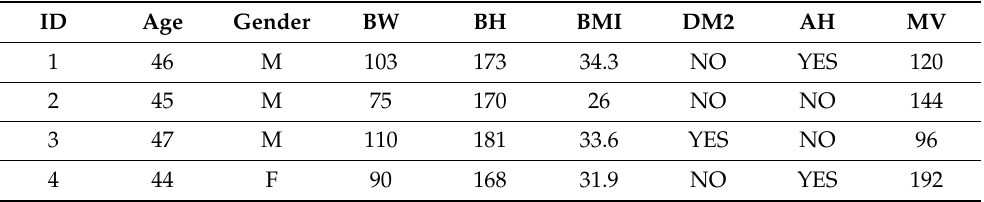
Figure 1. Computed tomography scans prior to segmental lung recruitment. CT scans showing different sections of lung: apical lung ( top left picture), middle part of the lung ( top right and bottom left picture) and basal lung ( bottom right picture). Table 1. Demographic data, co-morbidity and time spent on mechanical ventilation prior to segmental lung recruitment.